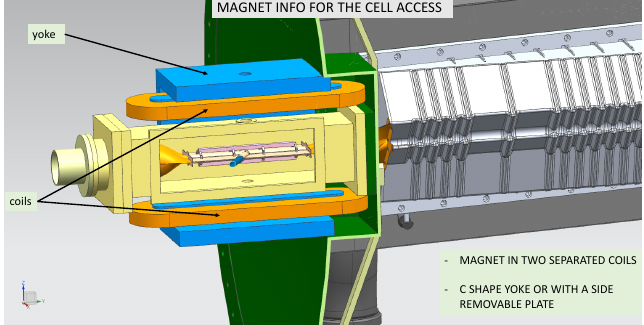
Figure 4: The TC drawing with the magnet coils (orange) and the iron return yoke (blue) enclosing the storage cell. The VELO vessel and detector box are shown in green and grey,